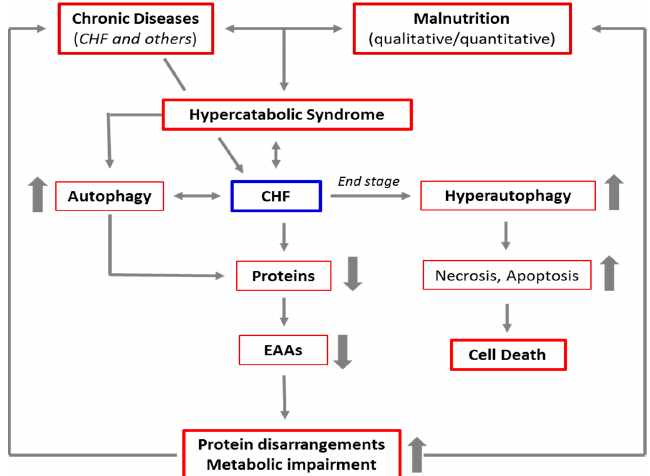
Figure 2. Schematic representation of the link between chronic diseases, malnutrition, hypercatabolic syndrome, and autophagy. The increase in catabolism induced by chronic diseases and malnutrition favors the activation of autophagy to guarantee the cells sufficient energy and materials to cope with accelerated metabolism. This results in a cascade of events, leading to protein disarrangements (the severe alteration of the protein components of the body), and then to metabolic impairment. This creates a vicious circle which, in the absence of adequate nutritional interventions, maintains and favors the hypercatabolic syndrome. Furthermore, in patients with advanced chronic diseases, like the end stage of CHF, autophagy is severely triggered, and the autophagic machinery may also drive the cells to